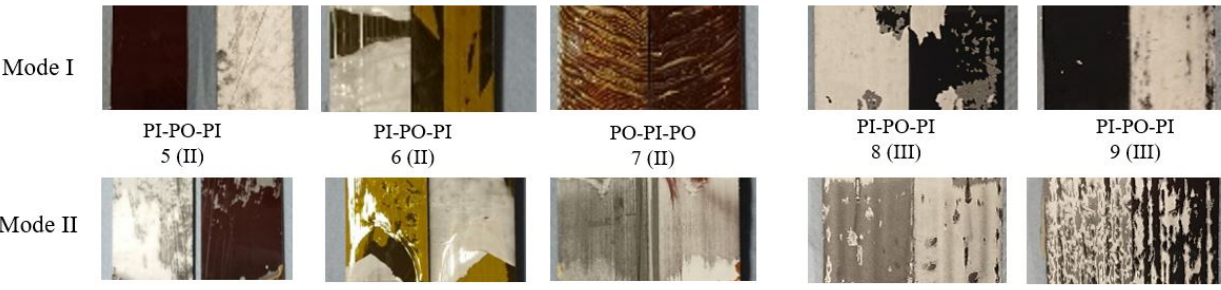
Figure 9. Representative fracture surfaces resulting from Mode I (DCB) and Mode II (ELS) testing for embedding configura- tions II and